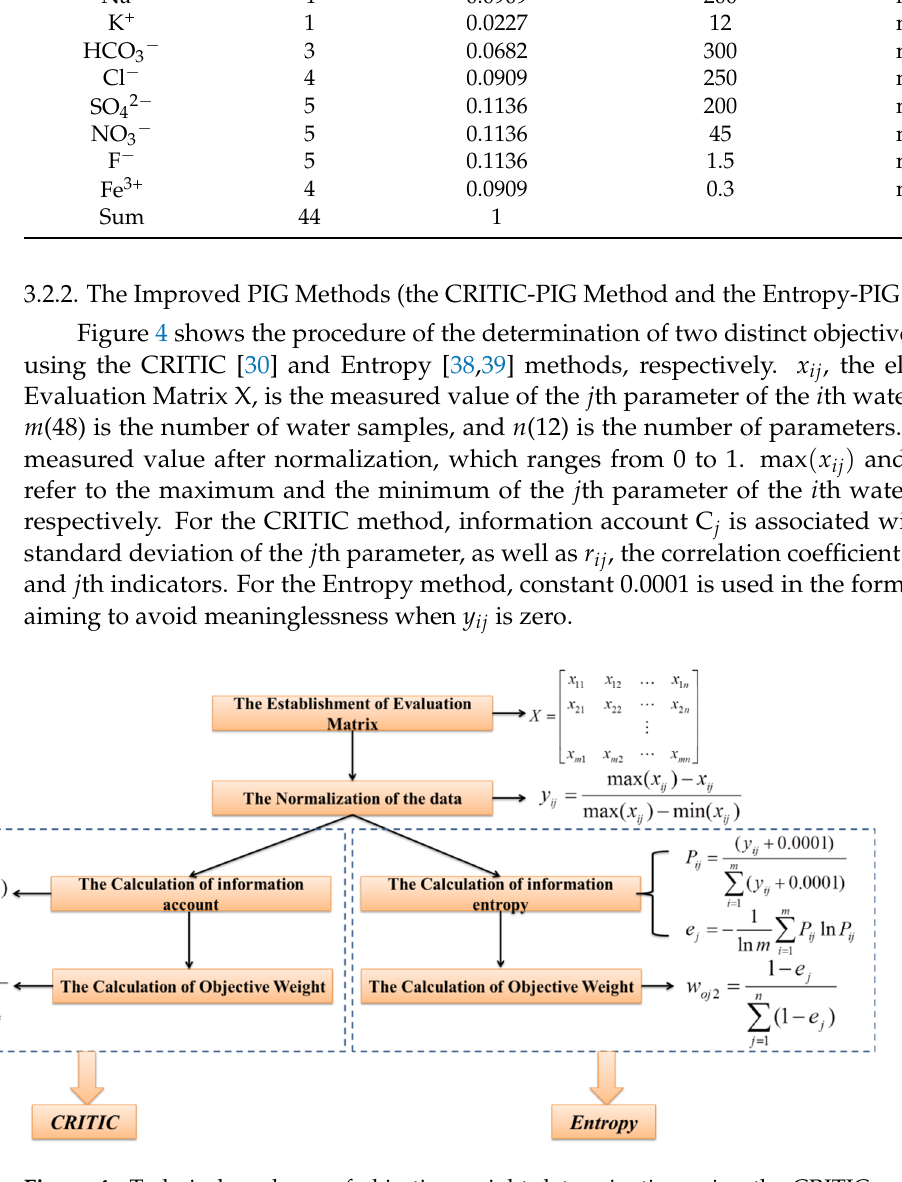
Figure 4. Technical roadmap of objective weight determination using the CRITIC and Entropy methods,